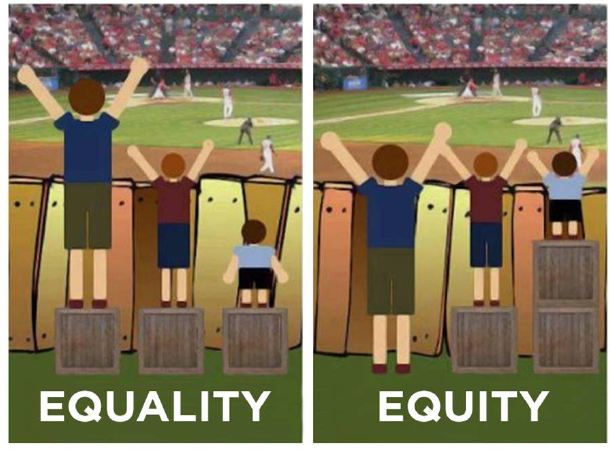
Figure 1 This image was adapted from the original graphic: http://indianfunnypicture.com/img/2013/01/Equality-Doesnt-Means-Justice-Facebook-Pics.jpg. Note that the Equity picture is based on the equality of the outcome – children of diverse heights have the same